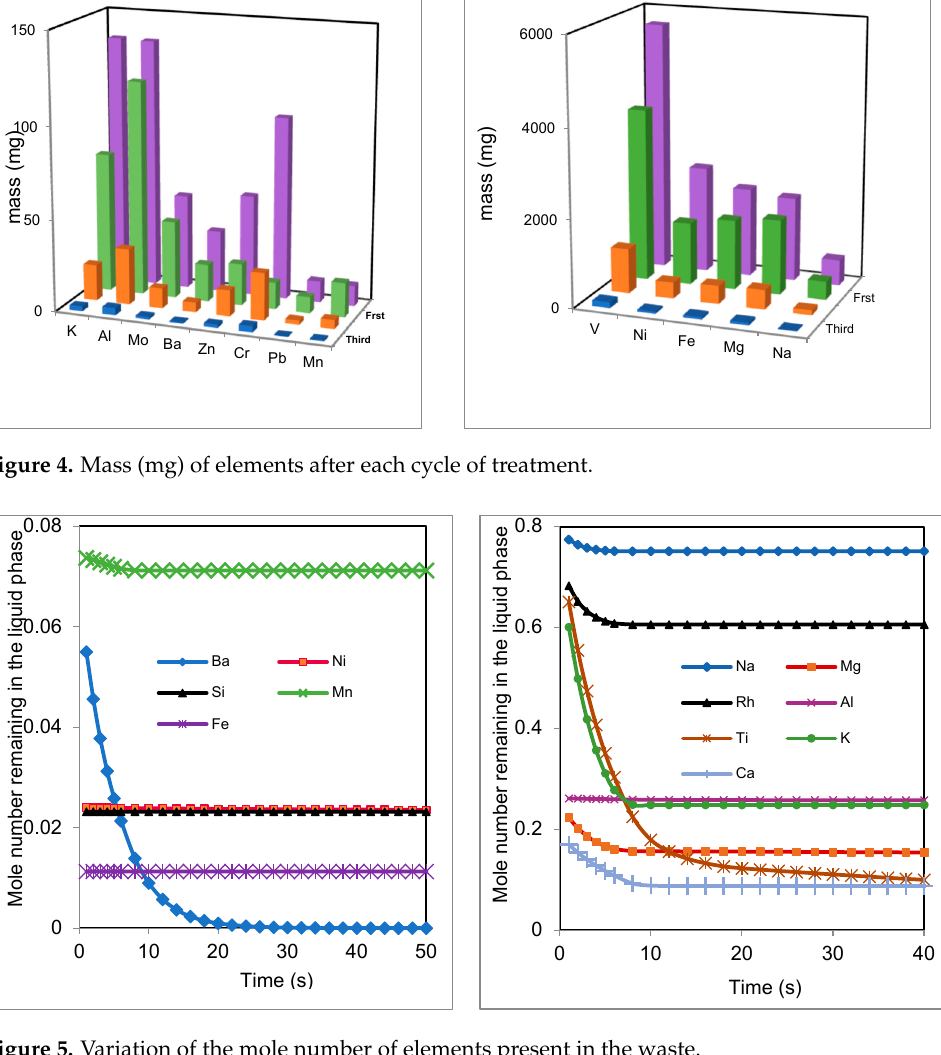
Figure 5. Variation of the mole number of elements present in the waste.